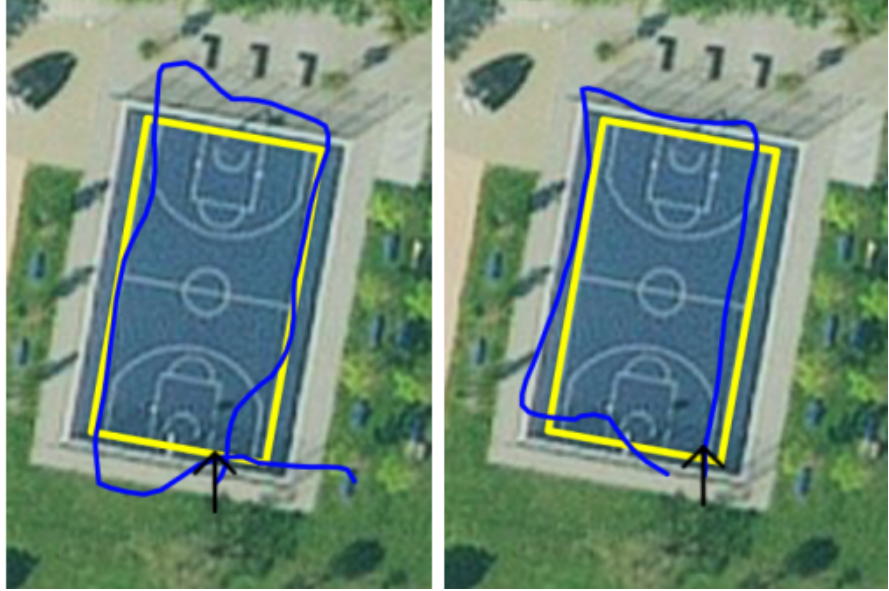
Figure 16. GPS signal in 15 November 2022 11:43:21.json ( left ) and 15 November 2022 11:34:23.json ( right ). Table 4. Evaluation (Datasets 1 and 2): GPS; distance to correct point on the ground